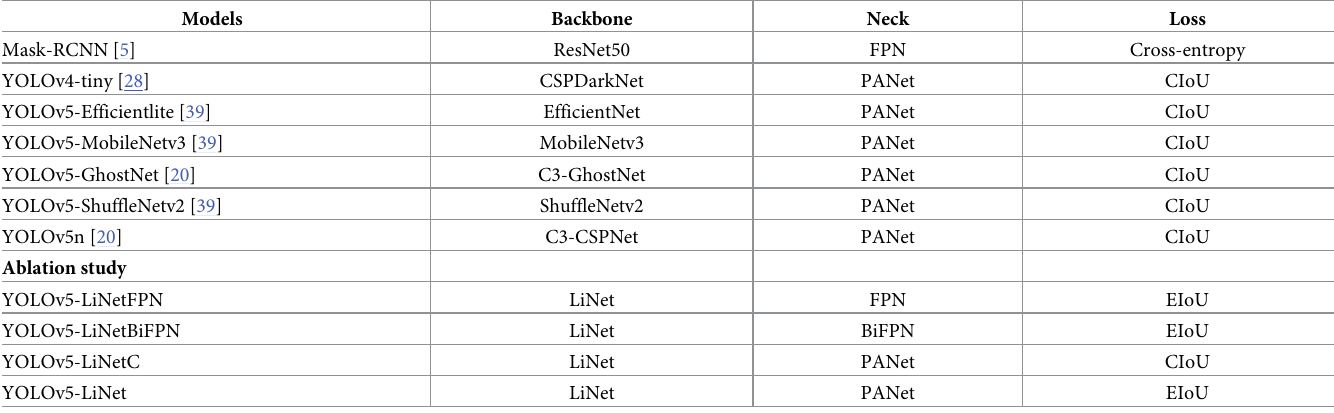
Table 1. List of trained